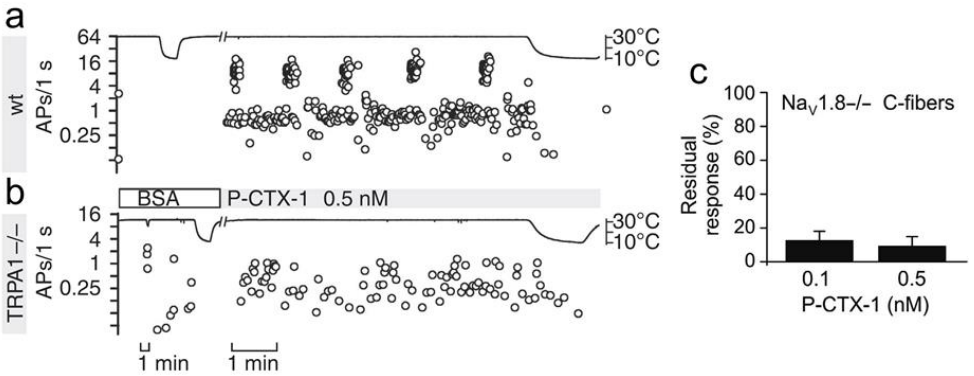
Figure 3. P-CTX-1 sensitizes C-type sensory fibers to cold in a Nav1.8- and TRPA1-dependent manner. nerve preparations from wild-type (wt) mice ( a ) and TRPA1-deficient mice ( b ). Residual cumulative action potentials induced in 5 min in single C-fibers from Nav1.8-deficient mice ( c ) compared with